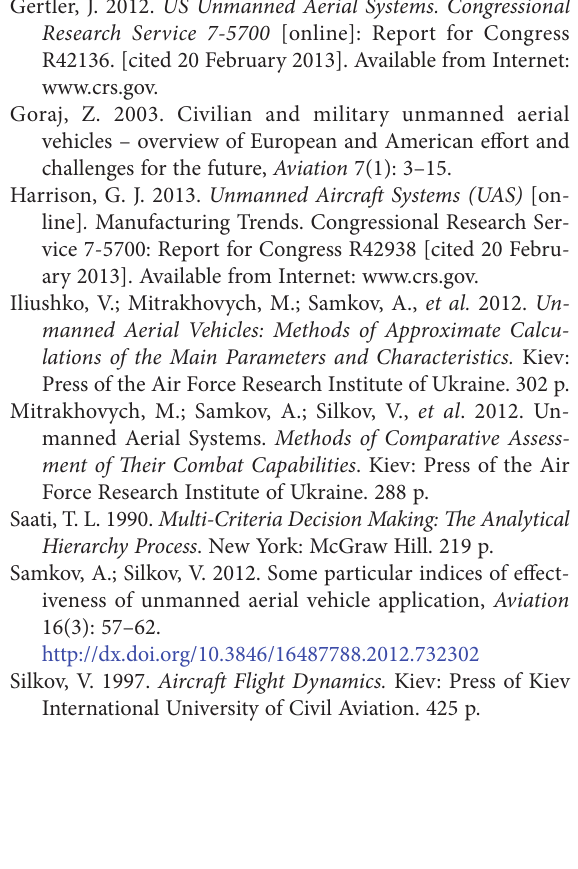
Unmanned aerial